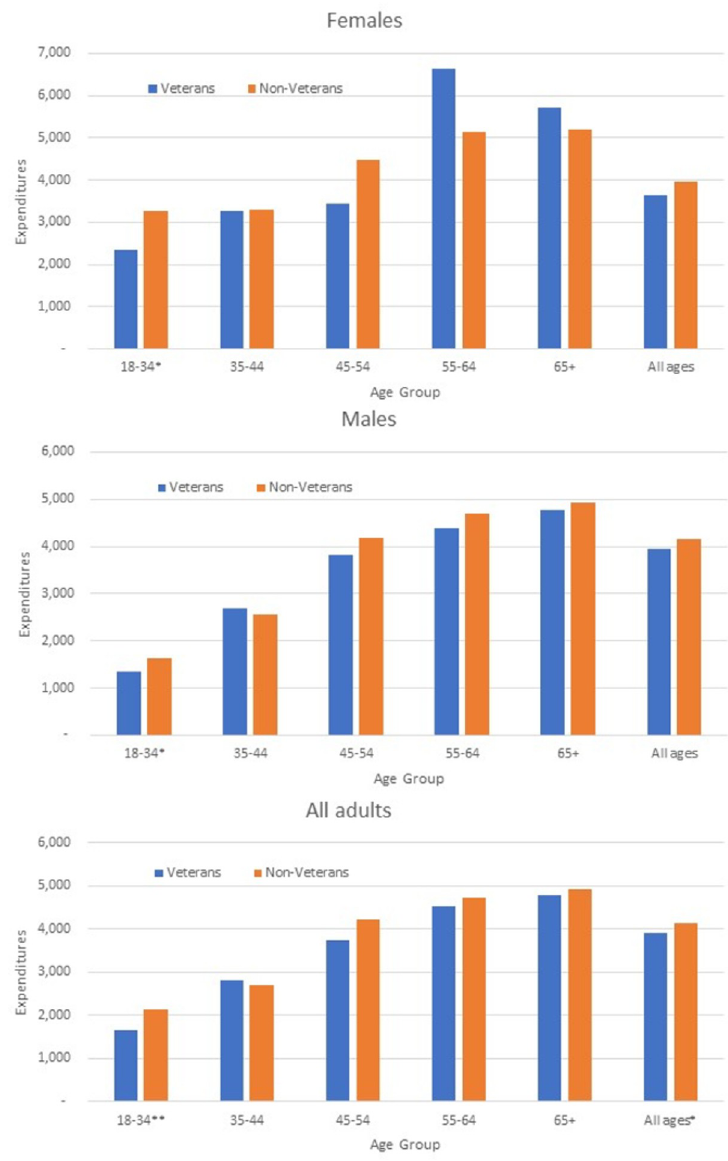
Fig 1. Average annual treatment cost estimates for American Indian/Alaska Native veterans and non-veterans by gender and age group. Fiscal year 2013.